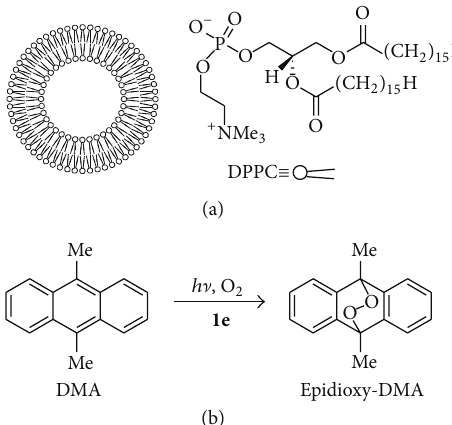
Scheme11:(a)PhospholipidliposomewhichwaspreparedbyDPPC and (b) photosensitized oxidation of DMA with 1e